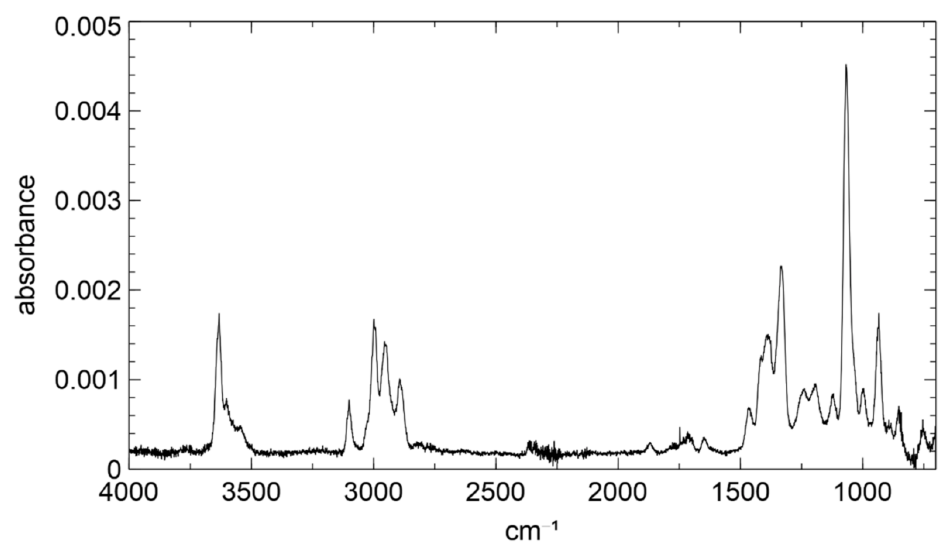
Figure 2. Gas phase FTIR Spectrum of